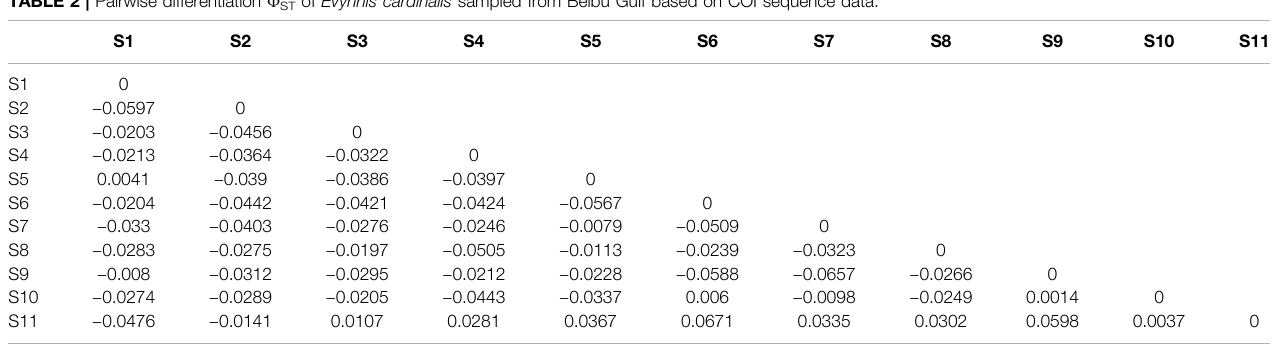
TABLE 2 | Pairwise differentiation Φ ST of Evynnis cardinalis sampled from Beibu Gulf based on COI sequence data.